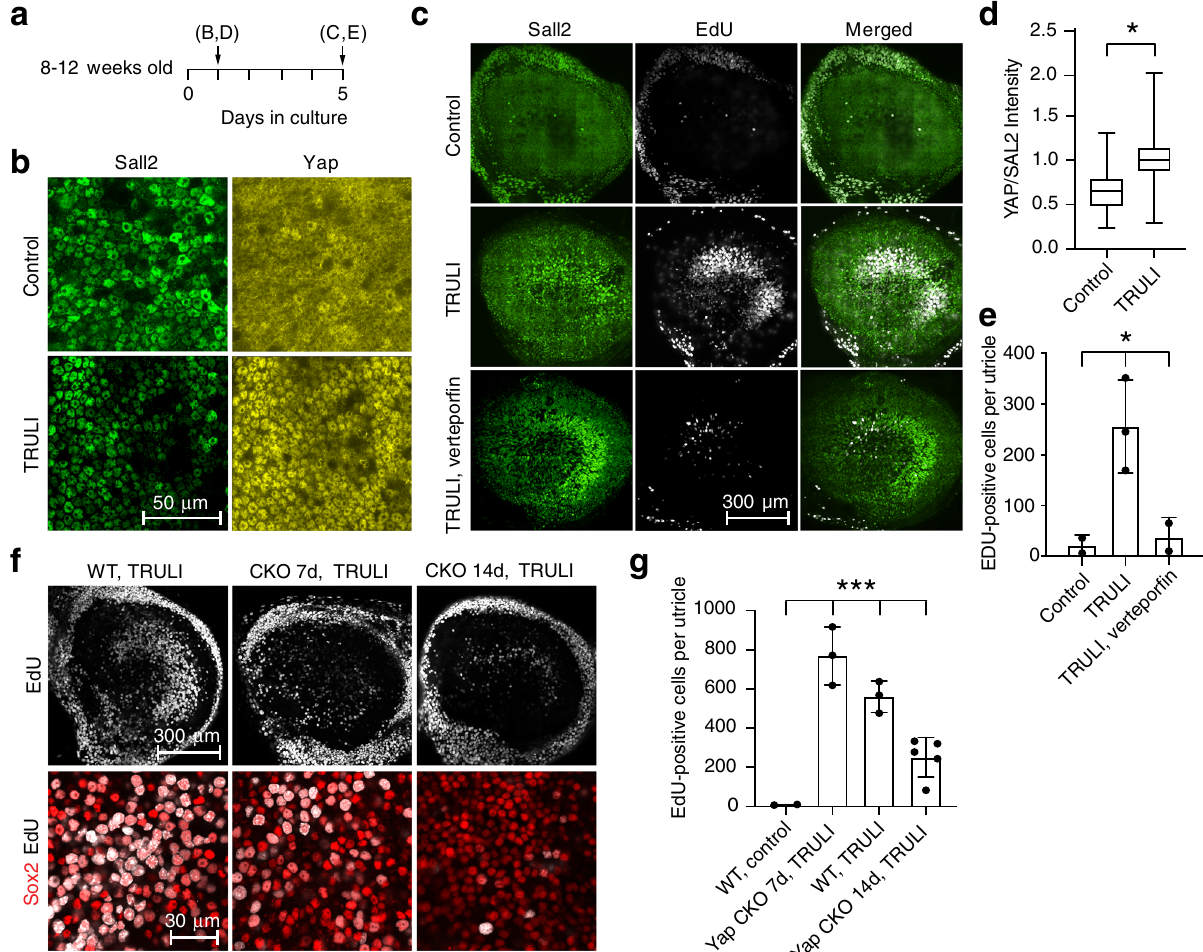
Fig. 2 TRULI mediates activation of Yap and proliferation of supporting cells. a A timeline depicts the pattern of the experiments shown in the indicated subsequent panels. Treatment of murine utricles with TRULI is initiated at the outset. b TRULI exposure drives Yap into the nuclei of utricular supporting cells. c In vitro exposure to TRULI for 5 days elicits proliferation of supporting cells, as measured by the incorporation of EdU. Vertepor fi n, an inhibitor of the Yap – Tead interaction, drastically reduces this effect. d In a whisker box plot, the nuclear localization of Yap is quanti fi ed as a ratio to the constitutively expressed protein Sall2 ( p = 2.683 × 10 − 170 , by an unpaired, two-tailed t -test, n = 570 control nuclei and 680 treated nuclei). e The number of EdU- positive cells per utricle increases with TRULI ( p = 0.0309 by one-way ANOVA, control n = 2, TRULI n = 3, vertepor fi n plus TRULI n = 2, mean ± SEM). f Conditional deletion of Yap by tamoxifen administration to SOX2-Cre ER Yap fl / fl (Yap CKO) animals at P1, 7 or 14 days prior to explanation, decreases the number of Sox2 (red) and EdU (white) doubly positive supporting cells compared to Cre-negative Yap fl / fl (WT) littermates. g Quanti fi cation of the number of EdU-positive cells in panel f demonstrates that decrease in supporting-cell proliferation is statistically signi fi cant ( p = 1.2798 × 10 − 7 by one-way ANOVA; n = 3 for wild-type control and Yap CKO at 7 days; n = 4 for TRULI treatment; n = 6 for Yap CKO at 10 days and TRULI, mean ± SEM). See also Supplementary Fig.